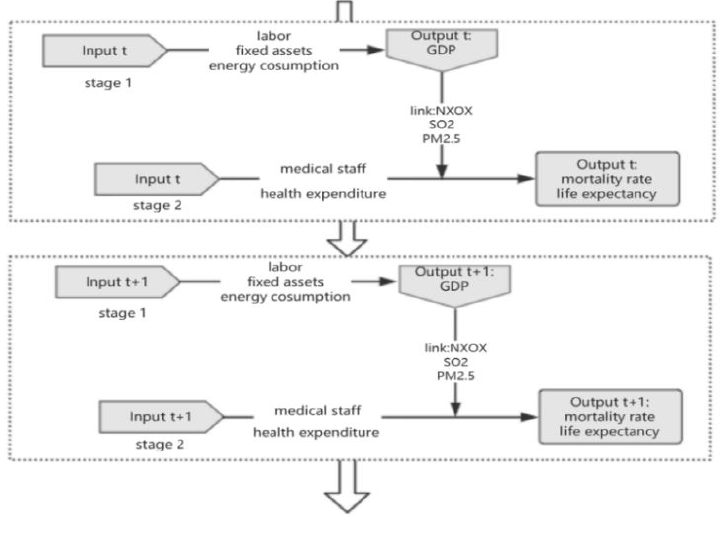
Figure 1. Network Figure 1. Network model.